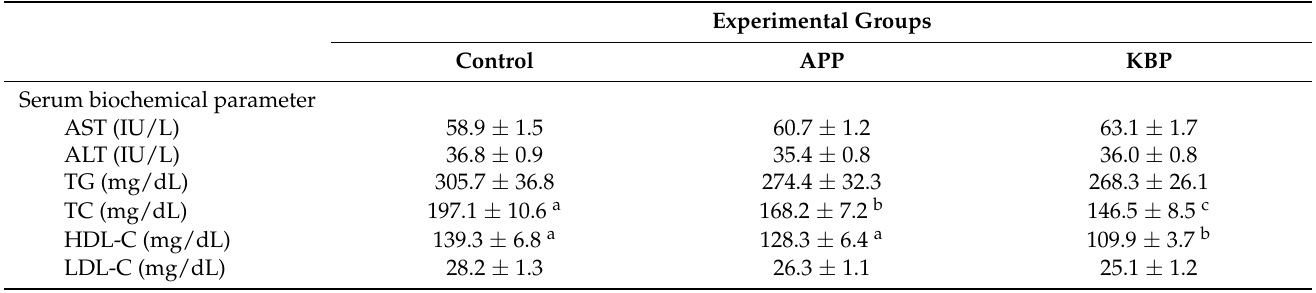
Table 4. Effect of dietary casein, APP, and KBP on the rat serum, liver, and fecal biochemical